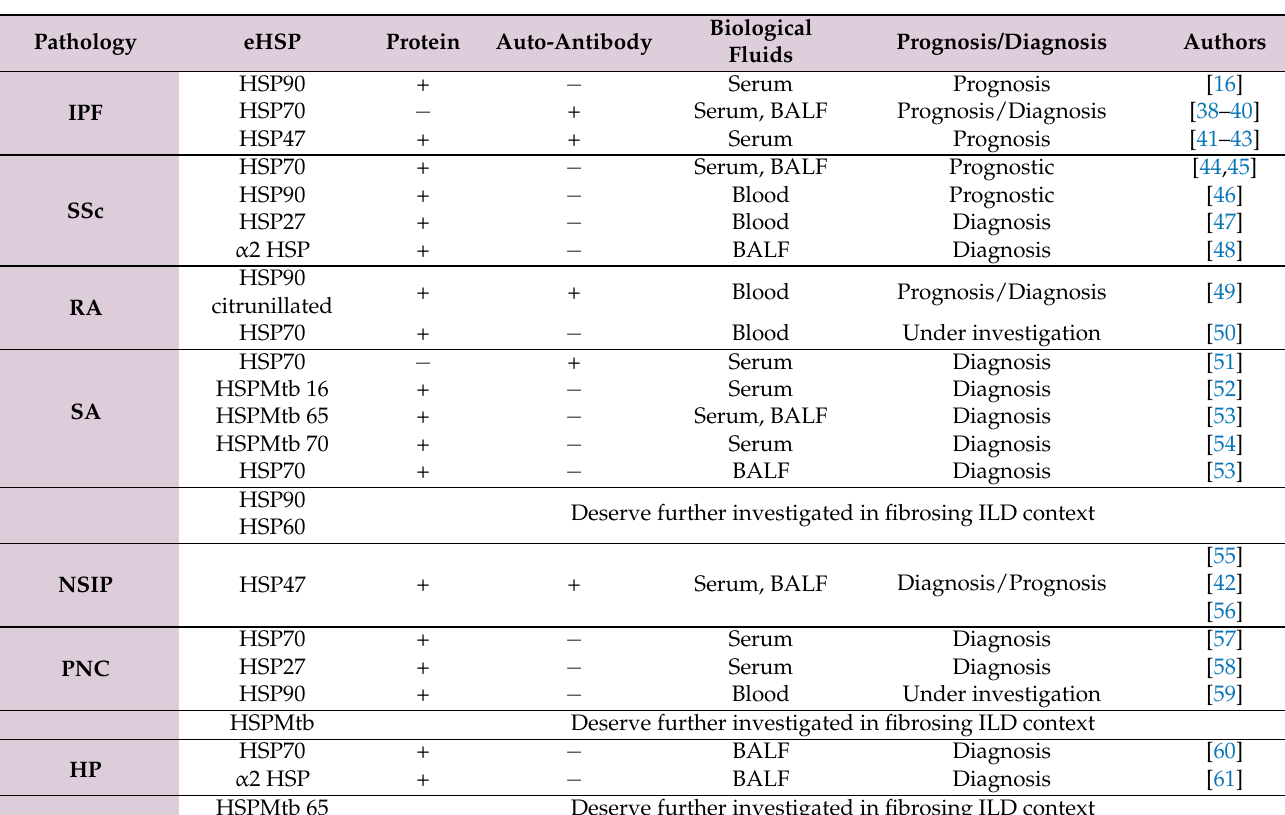
Table 2. Incorporation of pathogenic roles of eHSP in ILDs that implicate their roles as biomarkers and as therapeu- tic